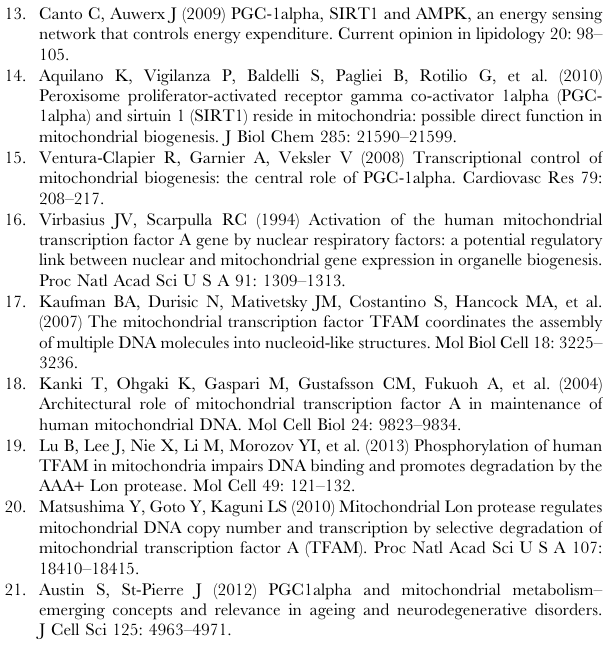
400x, scale bar shows 500 m m). Figure S2 Ki-67 index distribution in different EOC subtypes. Distribution of Ki-67 index varied significantly across the different EOC subtypes (Mann-Whitney U, p = 0.003). High- grade serous carcinoma (HGSC) ( n = 21), clear cell (CC) ( n =14), endometrial carcinoma (EC) ( n = 10), mucinous carcinoma (MC) ( n = 7) and low-grade serous carcinoma (LGSC) ( n = 1). (TIF) Figure S3 Ki-67 index distribution in EOC tumours depending on expression of PGC1 a and TFAM. Distribu- tion of Ki-67 index varied significantly across the different groups of tumours with PGC1 a -/TFAM- ( n = 9), PGC1 a -/TFAM + ( n = 2), PGC1 a + /TFAM- ( n = 9) and PGC1 a + /TFAM + ( n = 33) (Kruskal-Wallis test, p = 0.048). Figure S4 Growth rates in EOC SKOV-3 cells and the multiresistant subline SKOV-3-R. Growth rates in SKOV-3 and SKOV-3-R cells assessed as cellular protein at given time points using the sulphorhodamine B assay ( n = 4). Data are expressed as fold increase from t = 0 h. S.E.M. error bars were too small to be visualized, except where shown. Figure S5 PGC1 a /TFAM expression and response to cisplatin treatment in SKOV-3 PPARGC1A siRNA knock- down cells. SKOV-3 cells were treated with PPARGC1A siRNA knockdown or siRNA negative control; (A) gene expression of PPARGC1A and TFAM was evaluated at 72 h post-transfection by qRT-PCR ( n =3). Expression levels were normalised to ACTB . Error bars represent S.E.M. (B) representative western